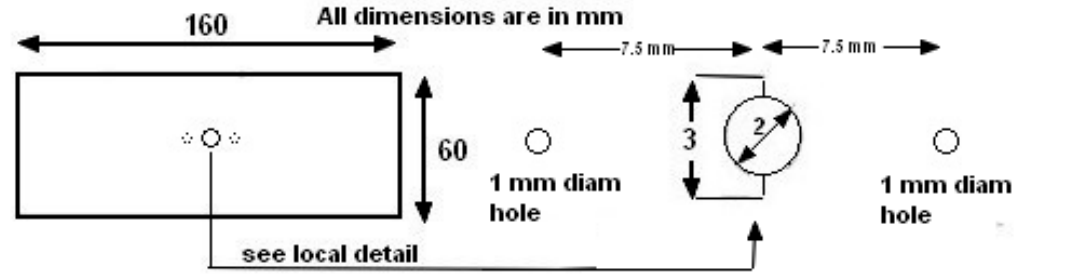
Figure 1. Schematic diagram of the MT specimen used.